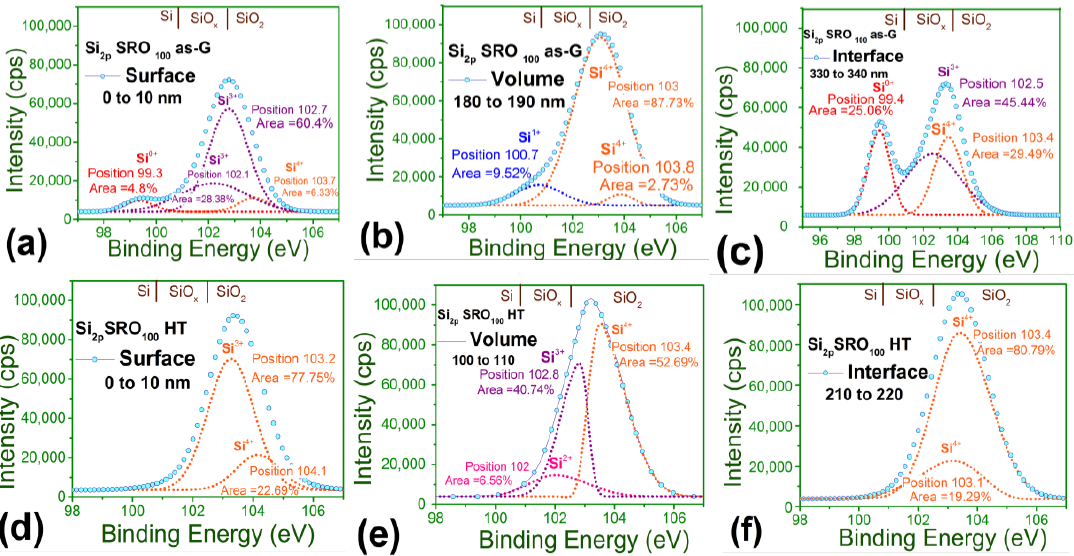
Figure 3. XPS spectra of Si 2p of single-layer films as-G and HT SRO 100 , with different oxidation-states, ( a ) and ( d ) on the surface, ( b ) and ( e ) in the volume, and ( c ) and ( f ) at the SRO/Si interface. Table 2. Oxidation phases of SRO 25 and SRO 100 single-layer films analyzed by XPS.